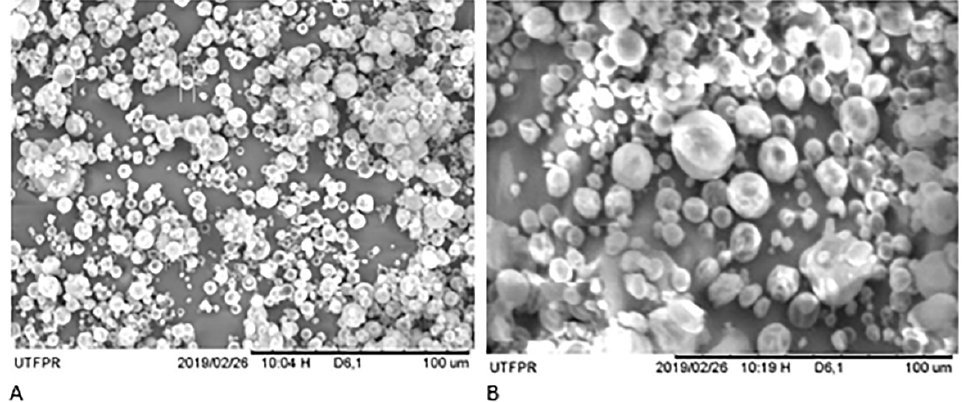
Figure 1. Microencapsulated extract of the propolis co-product. Magnifications: ( A ): 800×; ( B ): 1000×.